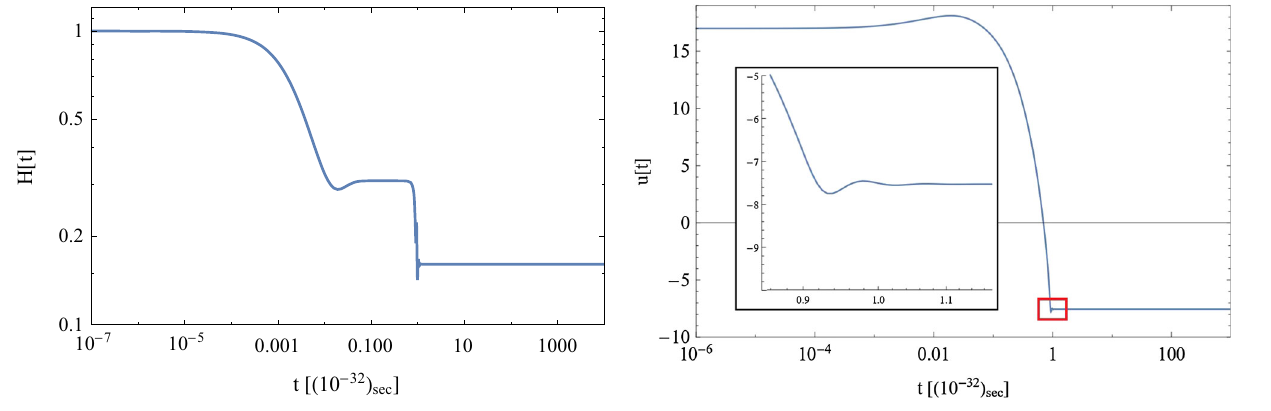
√ √ 16 π G Ne w ton ≡ M Planck / 2, and the unit for H is unit for u is 1 / around 10 − 17 sec − 1 or around 300 ( km / sec )/ Mpc which conforms to the current value of the Hubble parameter around 60 ( km / sec )/ Mpc. On the right panel the blown-up rectangle depicts the oscillations of u ( t ) around the minimum of U eff (19). One can see that the universe startswithaninflationaryHubbleconstantandendswithasmallervalue representing the dark energy